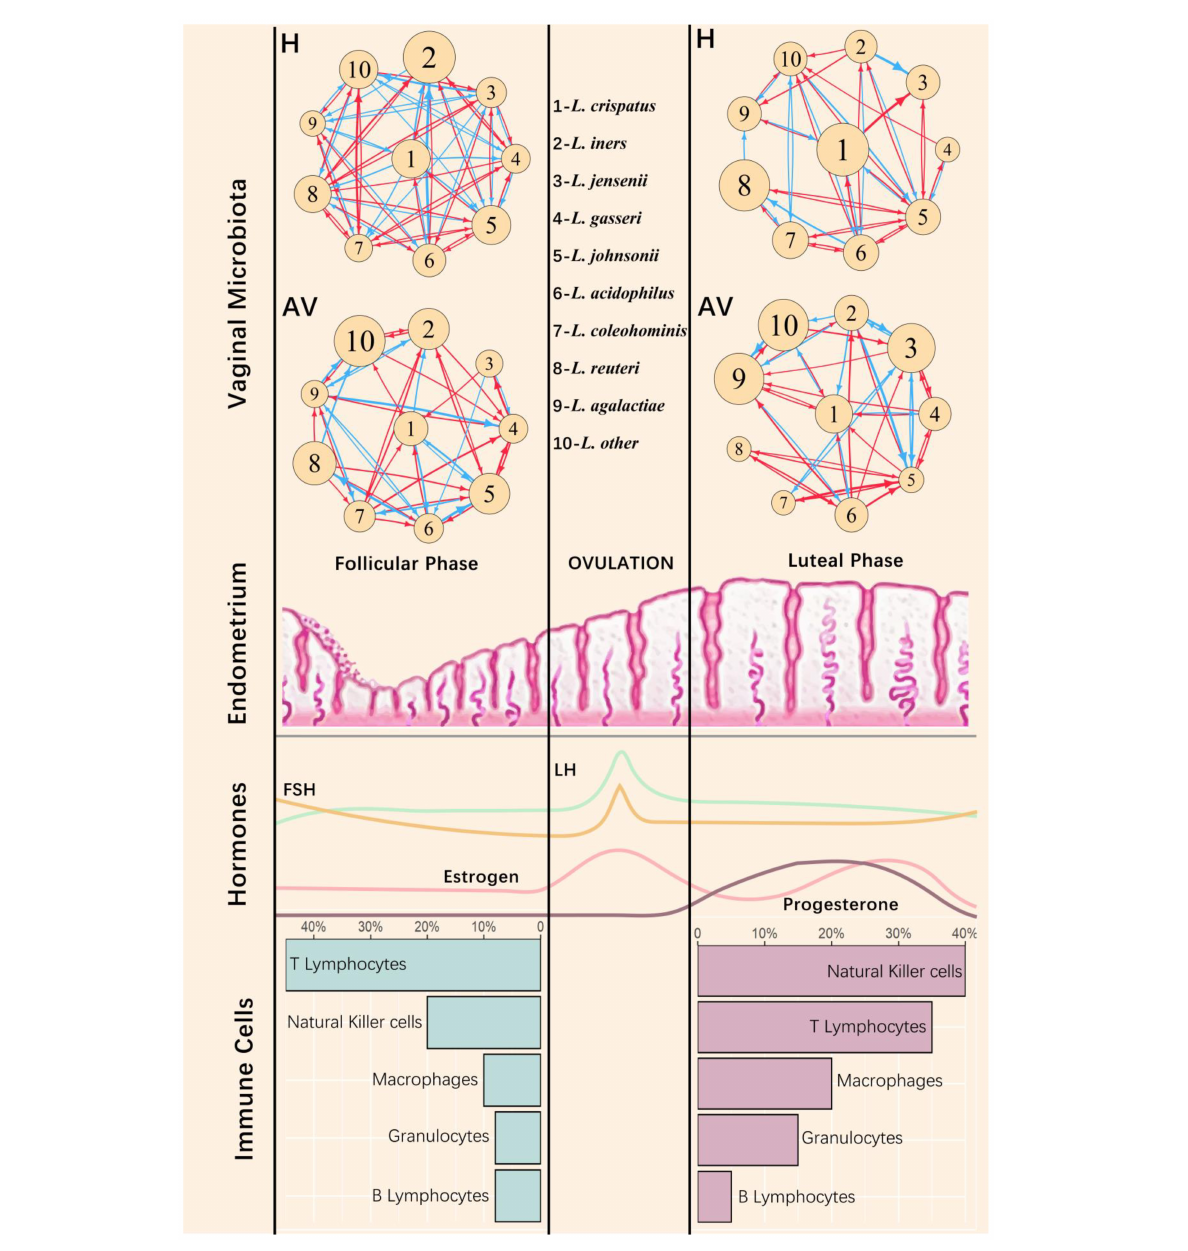
FIGURE7 Vaginal microbial networks in response to physiological changes of the endometrium during menstruation cycle. The repetitive cycles of the human endometrium among the follicle, ovulation, and luteal phases are accompanied by morphological changes and cyclical fluctuations of sex hormones [including estrogen, progesterone, follicle hormone (FSH), and luteinizing hormone (LH)] as well as different types of immune cells (Agostinis et al., 2019). At the top of the figure are the microbial networks composed of the nine most abundant Lactobacillus species (denoted as 1–9) and the remaining microbes (other) for healthy (H) and AV groups. The nodes of the networks represent the independent abundance components of individual microbes, with the size of circles proportional to the value of such components. The edges of the networks are directional promotion (red) or inhibition (blue) between a pair of